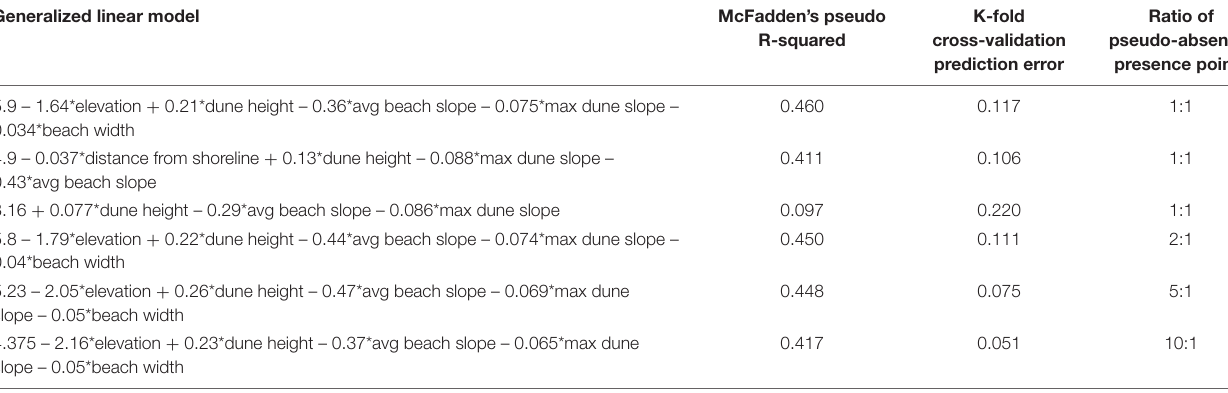
TABLE 3 | Generalized linear models created using varying ratios of pseudo-absence to presence points and their respective measures of accuracy. Generalized linear model McFadden’s pseudo